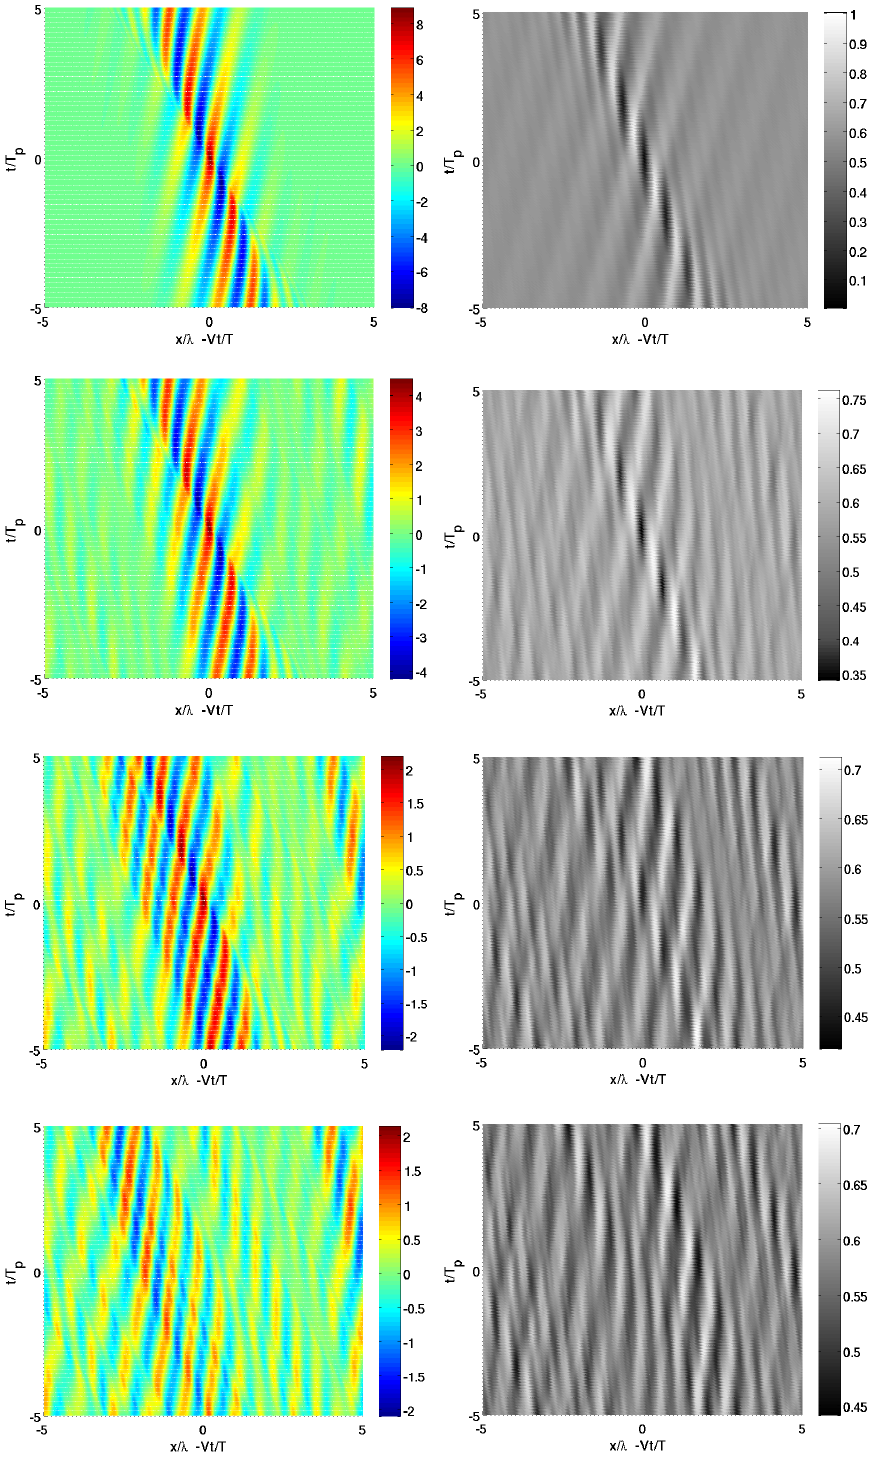
Fig. 4. In successive rows we show plots of the linear evolution of Jonswap waves with a random phase restricted for α = 0 , 0 . 6 , 0 . 8 and 1, respectively. At the left density plots are shown of the evolution in a frame moving with the group velocity (horizontal axis, time vertical axis with normalized units). At the right, with the same axis the evolution of the density of the phase variance is